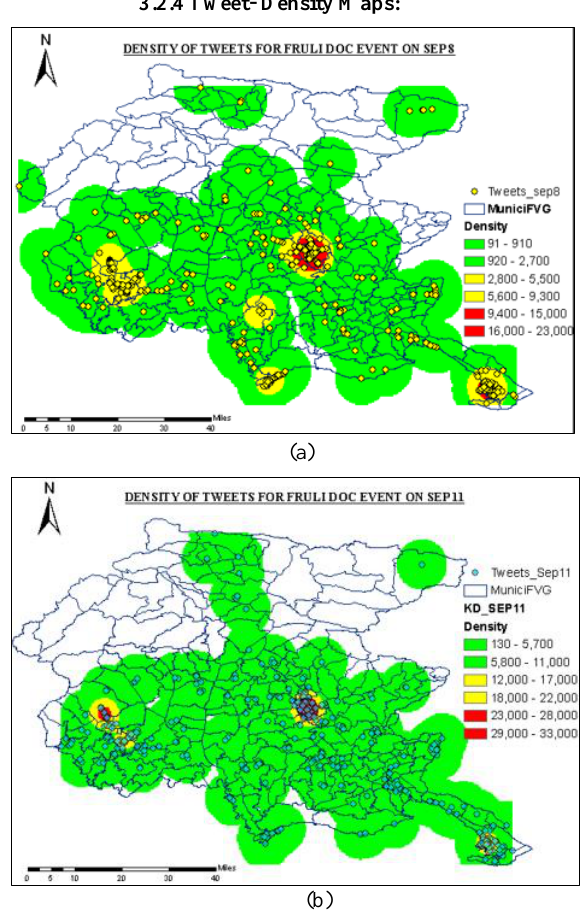
Figure 3.2.4-5 (a) & (b) Tweet Density on September 8 and 11  Above fig 3.2.4-5 a & b show the density of tweets in Udine for event. Tweets are filtered based on location (Udine), date. For Friuli doc event first and last day of the event